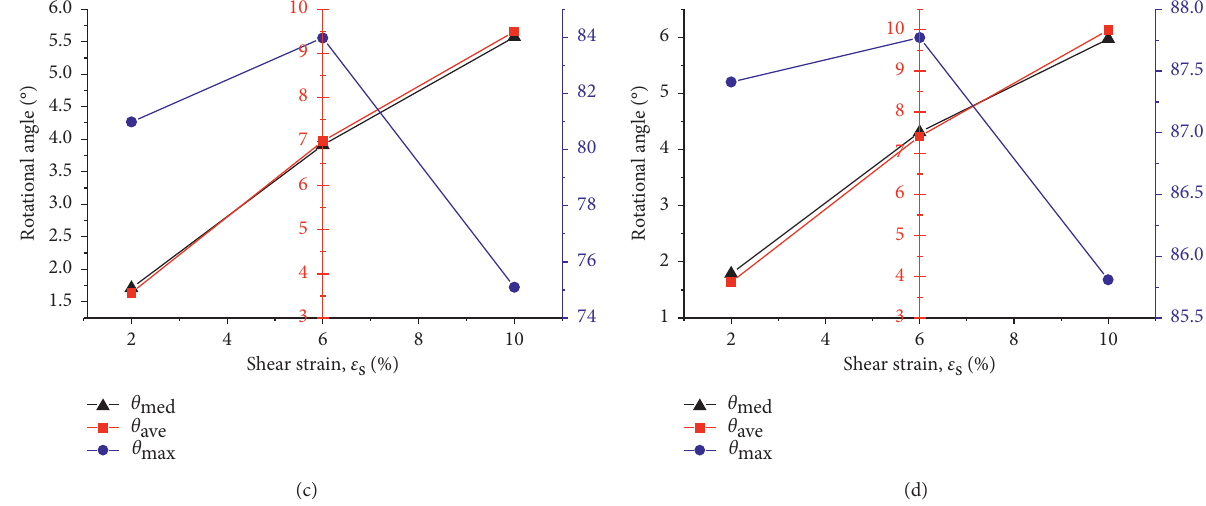
Figure 13: The maximum, medium, and average values of particle rotation about the positive y -axis: (a) σ (d) σ n � 75kPa.